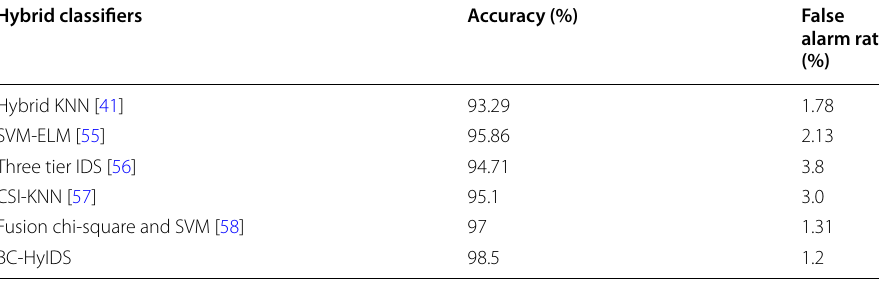
Table 9 Comparison of BC-HyIDS with existing IDS Hybrid